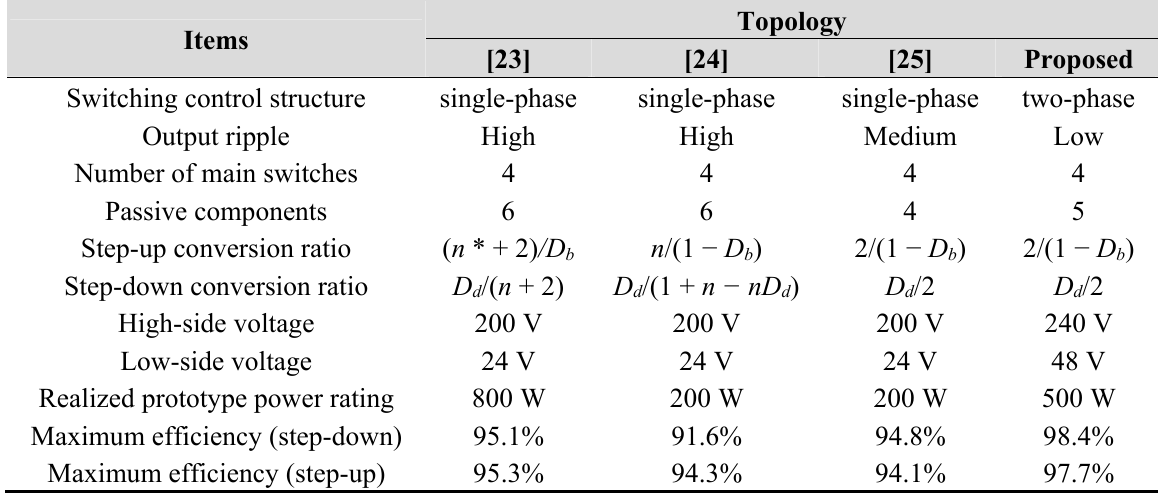
Table 2. Characteristic comparison among a variety of